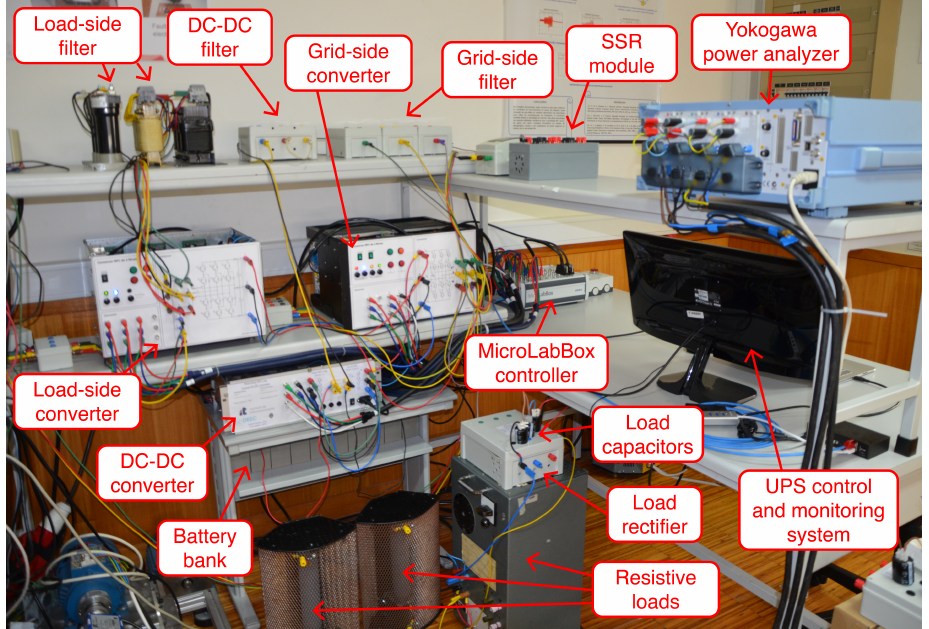
Figure 11. Experimental prototype of the proposed UPS system. All relevant circuit and controller parameters are shown in Table 4. Table 4. Experimental Circuit and Control